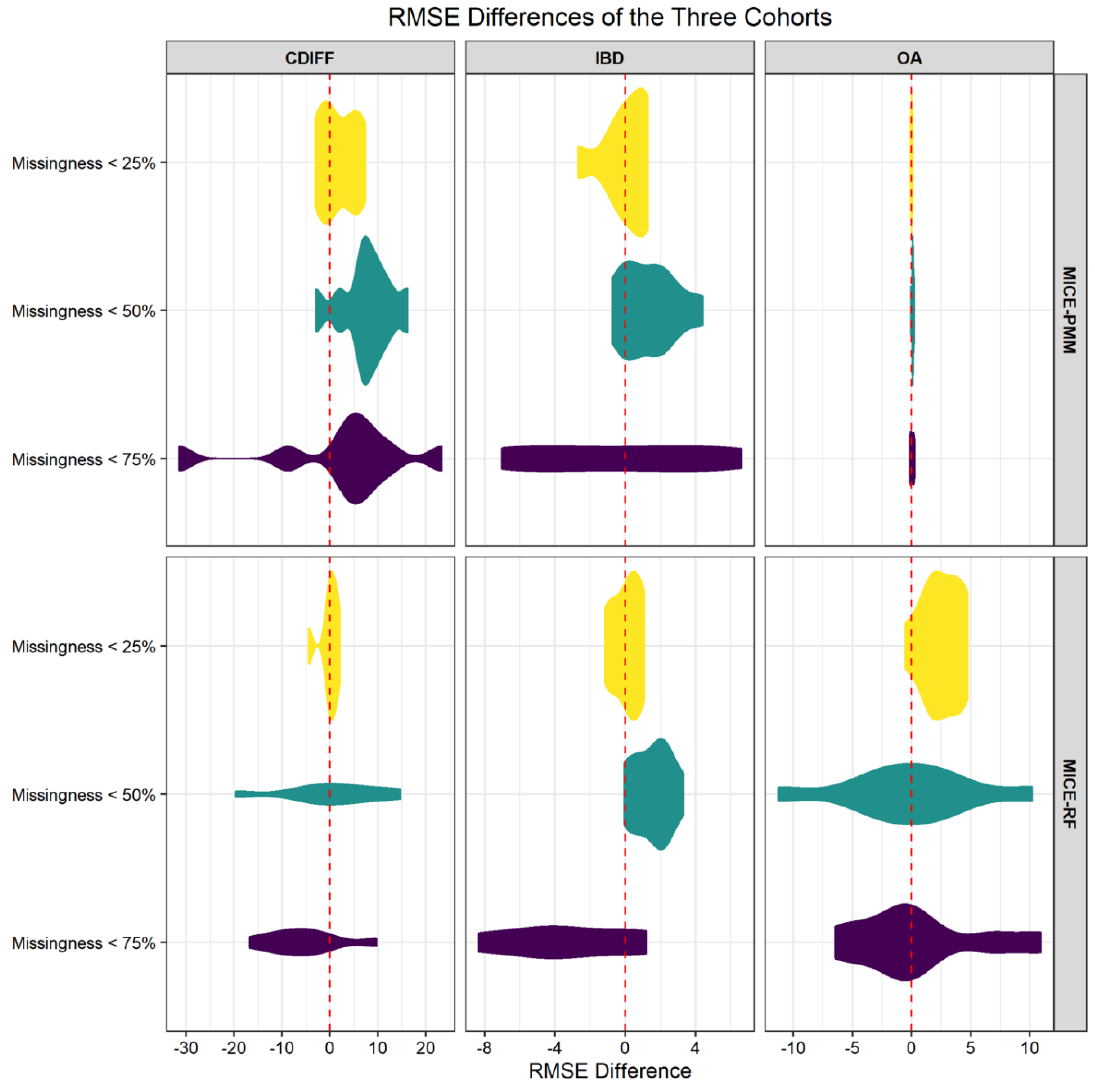
Figure 4. Violin plots representing the root mean square error (RMSE) differences—comparing the performance of Multivariate Imputation by Chained Equations (MICE) with and without the comorbidity information. Two algorithms, predictive mean matching (pmm) and Random Forest (rf), were compared. A Negative RMSE difference indicates a performance improvement when the comorbidity information is utilized. Table 1. The root mean square error (RMSE) difference from imputation is applied with and without the integration of comorbidity information for the three datasets. Negative RMSE correspond Table 3. A5 for a more comprehensive results, with p -values reported from multiple runs.